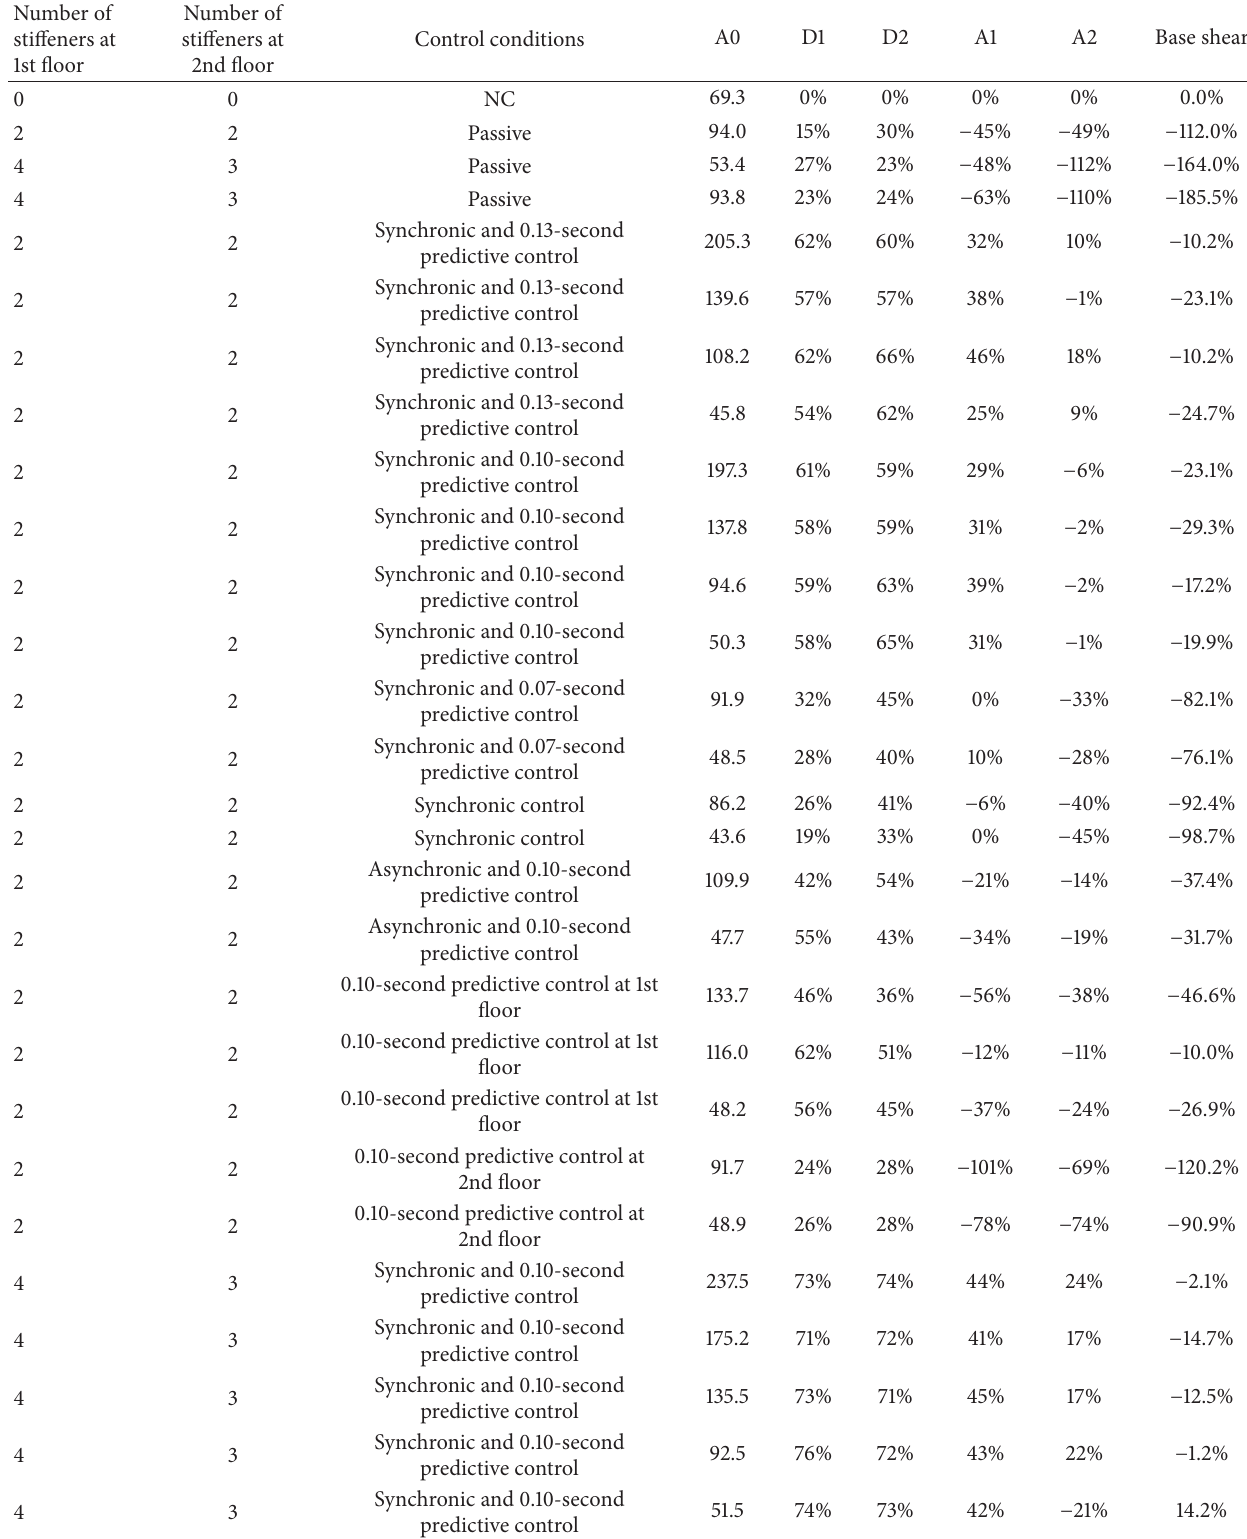
and different peak ground